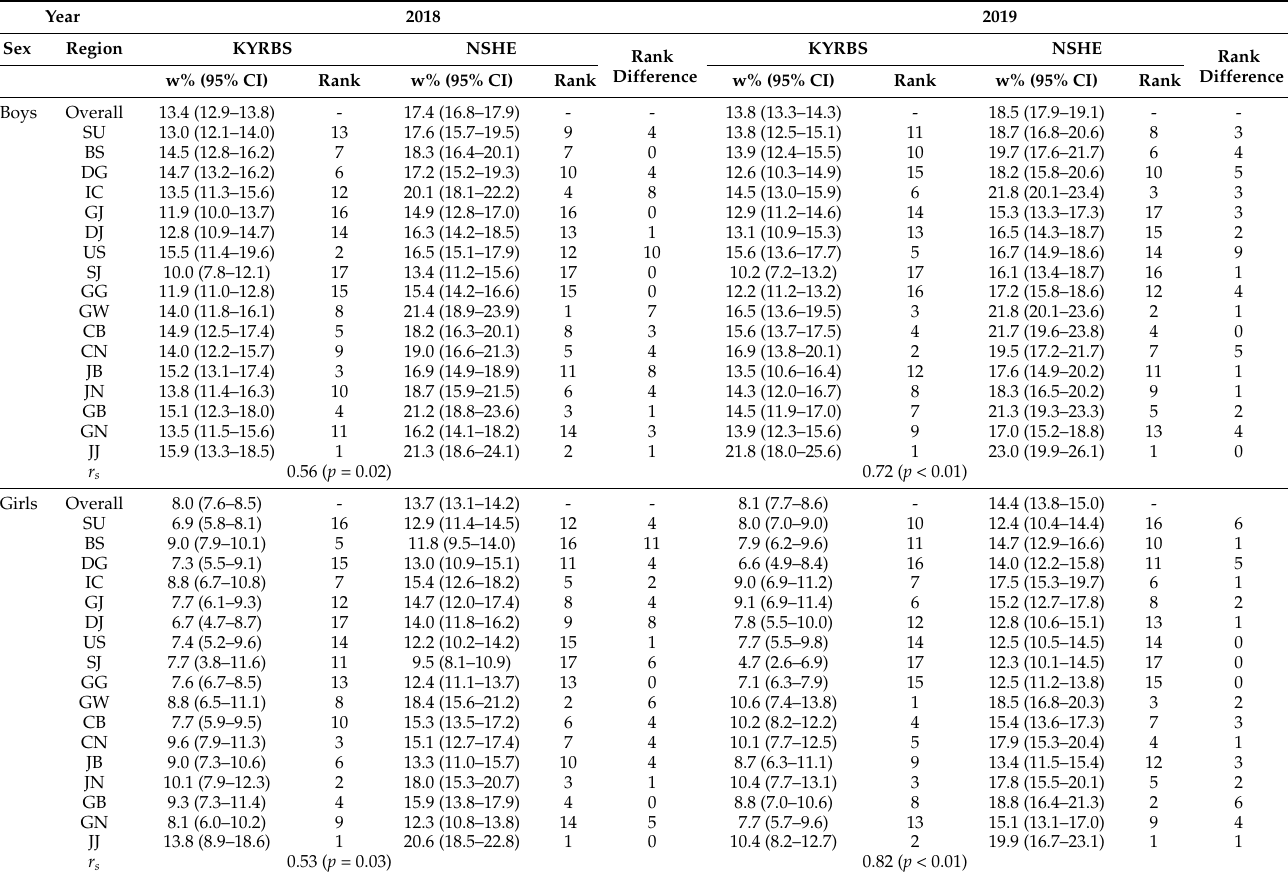
Table 2. Regional obesity prevalence and relative rankings from the KYRBS and NSHE